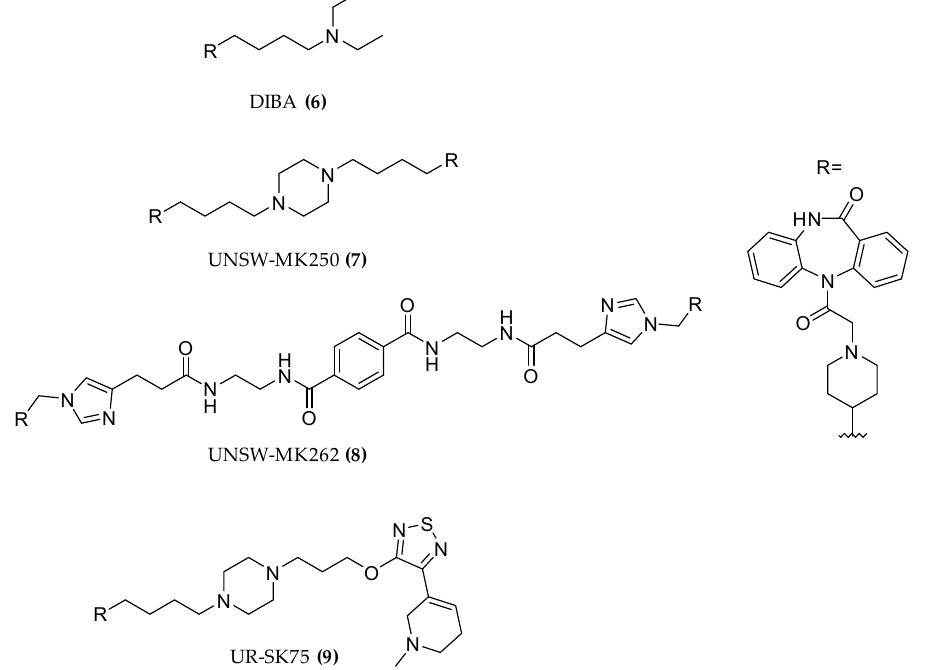
Figure 5. Structures of homo-hetero dimeric dibenzodiazepinone M2 derivatives.